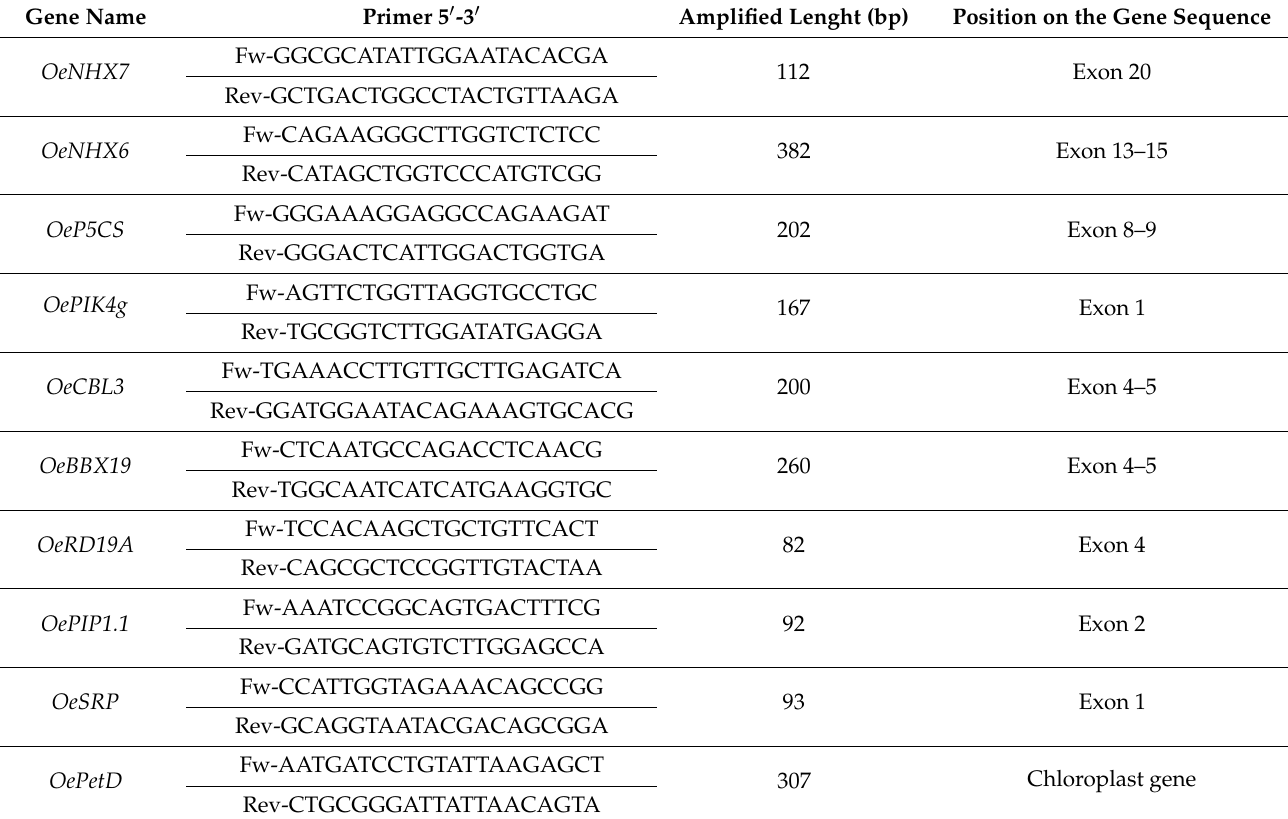
Table 3. Specific primers used for quantitative expression of ten candidate